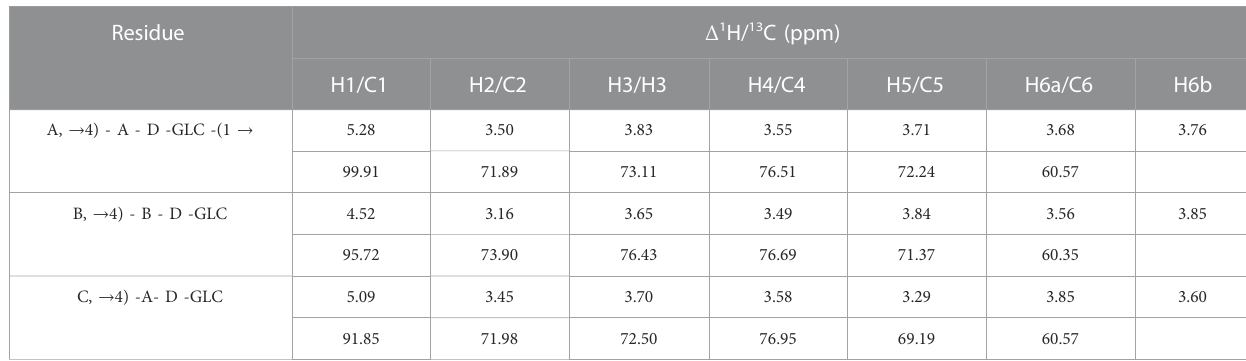
TABLE 1 1 H and 13 C NMR chemical shifts of